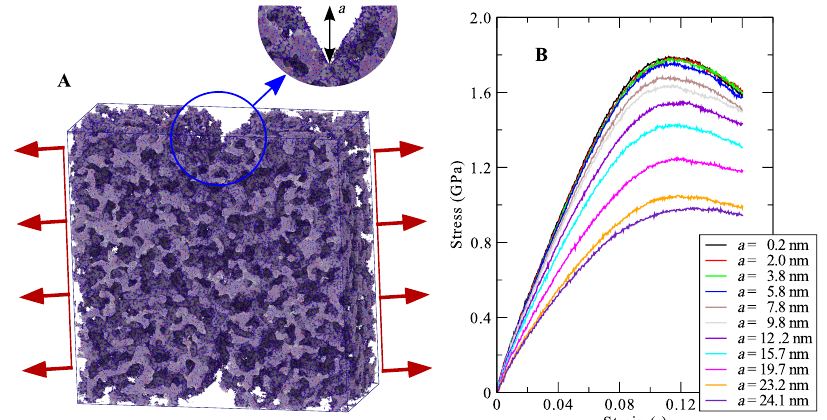
Figure 11. ( A ) Illustration of a MD model and initial notches of a silica aerogel sample with density of 645 kg m − 3 , where a (centre) refers to the notch depth. ( B ) Stress-strain trajectories extracted from MD simulations of silica aerogel models with a density of 1155 kg m − 3 and various notch depths